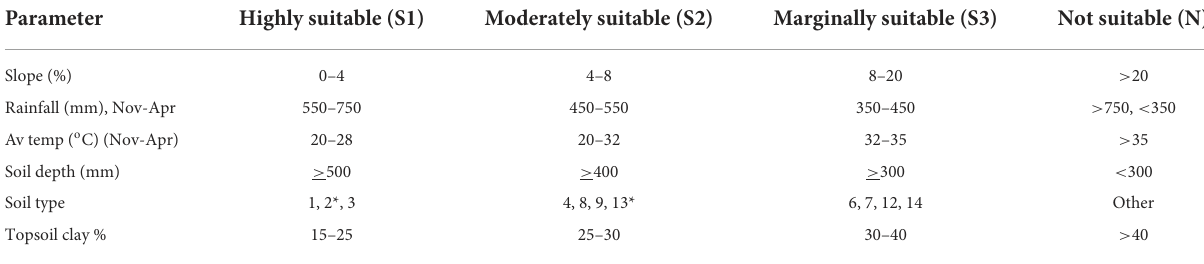
TABLE 2 Bambara groundnuts – crop suitability